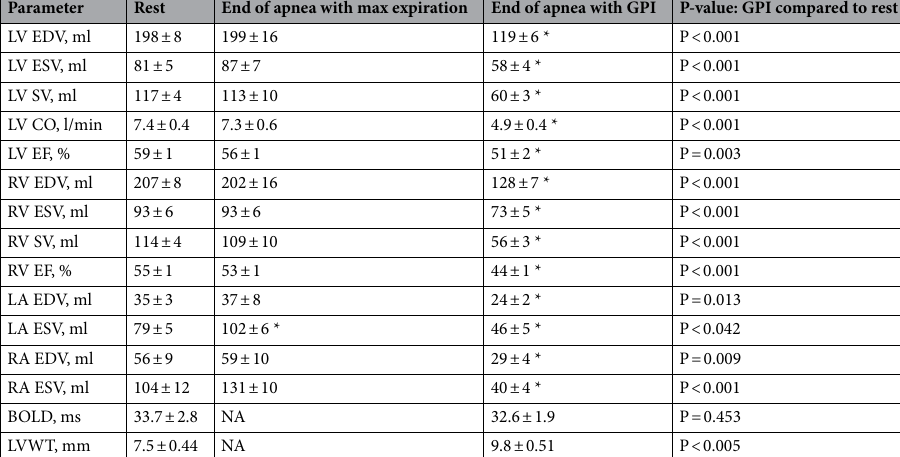
Table 3. Cardiovascular variables and organ volumes as evaluated with Cardiac Magnetic Resonance imaging at rest, at end of apnea with maximal expiration and at end of 240 s of apnea with glossopharyngeal insufflation (GPI) in 8 elite breath-hold divers. Values are means ± Standard Error of Means. *P < 0.05 vs. rest. GPI glossopharyngeal, insufflation; LV left ventricular; RV right ventricular; EDV end-diastolic volume; ESV end-systolic volume; SV stroke volume; CO cardiac output; EF ejection fraction; LA left atrial volume; RA right atrial volume; BOLD blood oxygen level dependent, LVWT left ventricular wall thickness.